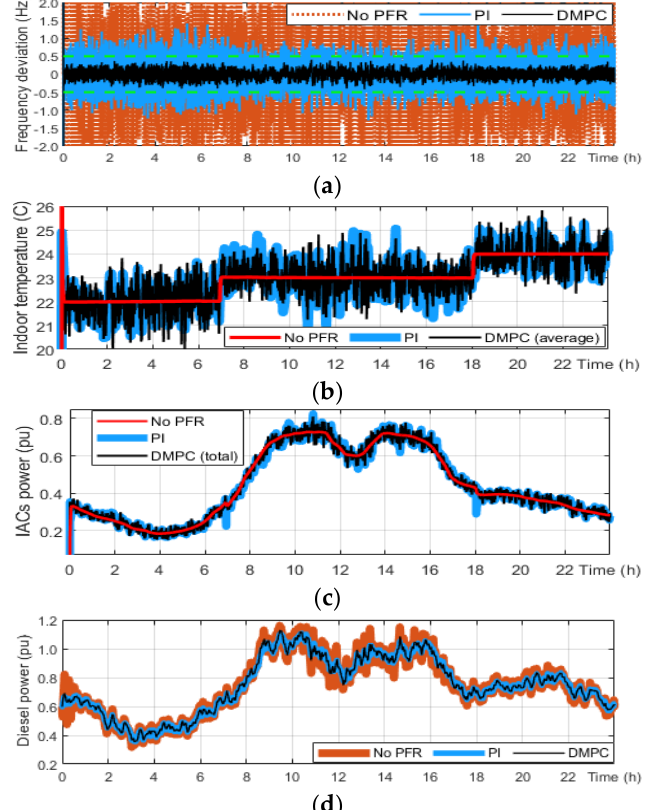
Figure 16. Simulation results of case 3 ( a ) frequency deviation, ( b ) indoor temperature, ( c ) IACs